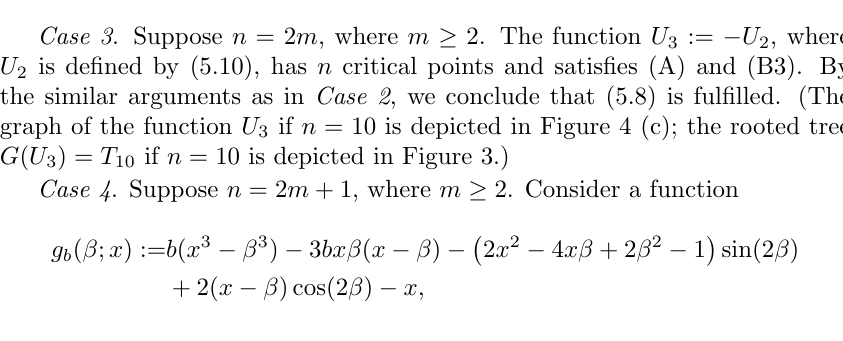
Figure 4. Illustration to the proof of Theorem